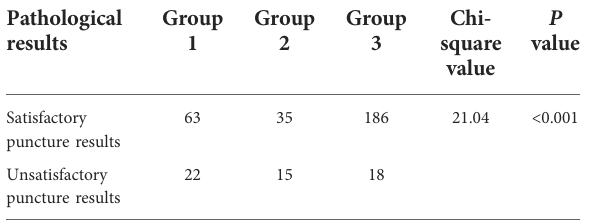
TABLE 3 Comparison between different capillary sampling needles and aspiration methods in terms of cytopathological satisfaction of thyroid fi ne-needle aspiration biopsy